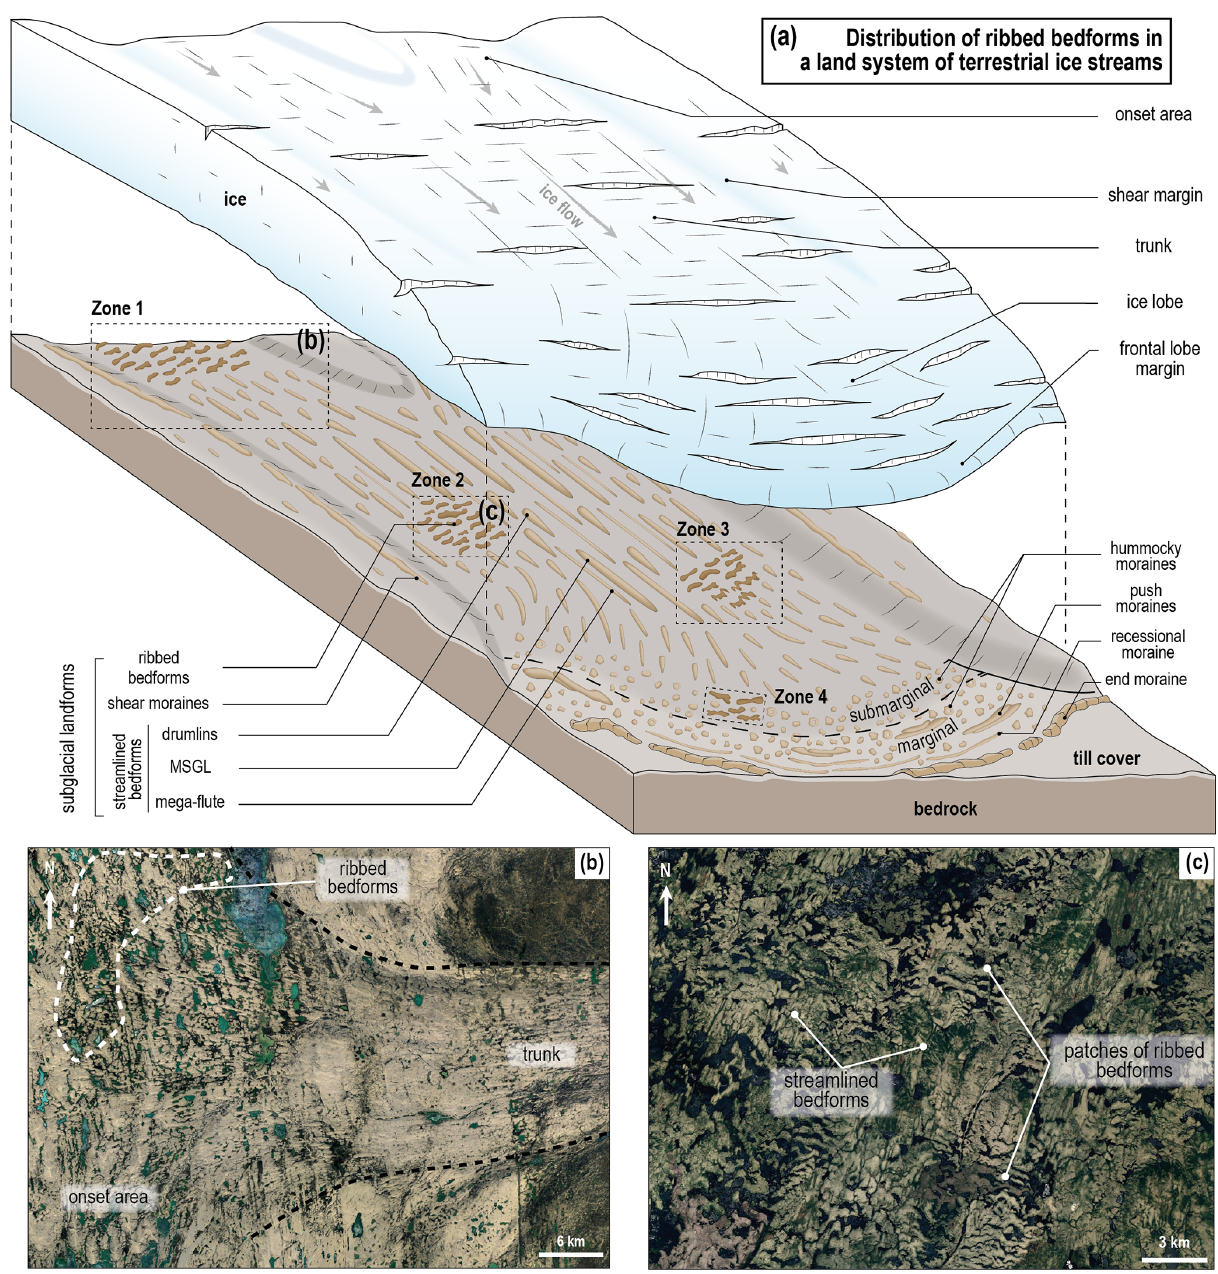
Figure 1. (a) Distribution of ribbed bedforms, as currently envisaged, in an “ideal” isochronous land system of terrestrial palaeo-ice streams (modified after Clark and Stokes, 2003). (b) Ribbed bedforms located in the cold-based onset area (Zone 1), upstream of the streamlined bedforms, recording the warm-based trunk of an ice stream (Fisher Lake, Prince of Wales Island, Canada). (c) Patches of ribbed bedforms with abrupt borders with surrounding streamlined bedforms (Zone 2; Lake Naococane, Canada). Also documented and shown in (a) , although not shown with specific examples, are progressive downstream transitions from ribbed bedforms to drumlins (Zone 3) and marginal relationships between hummocky and ribbed bedforms (Zone 4) (© Landsat/Copernicus – © Google Earth).